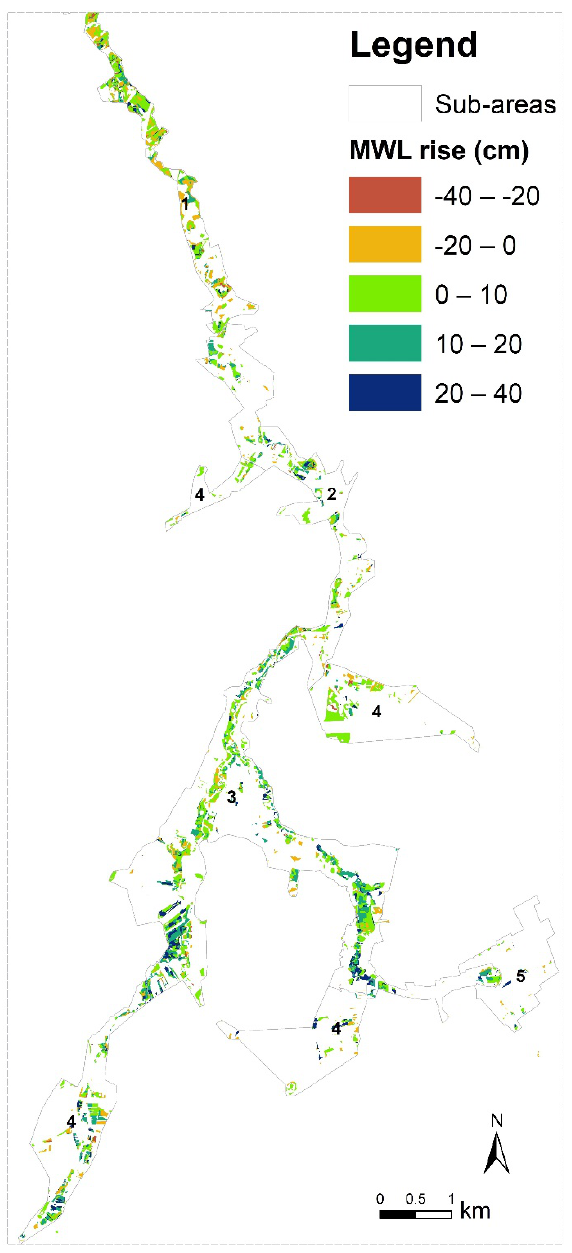
Figure 1. Changes in mean water level with green and blue colours indicating raised water level. The landscape is clustered into sub-areas: 1 = downstream, 2 = transition down-middle reaches, 3 = middle reaches, 4 = transition middle- upper reaches, 5 = source